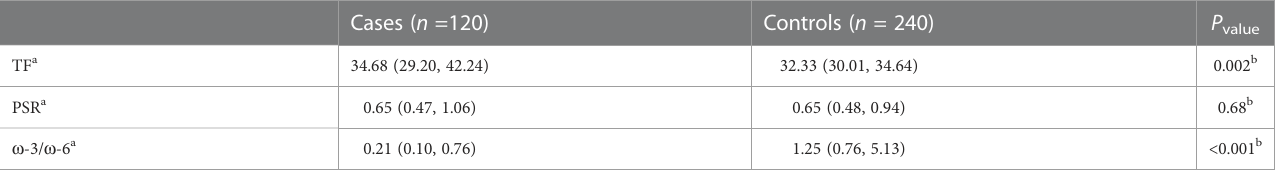
TABLE 2 Dietary fat quality indices of the study population.